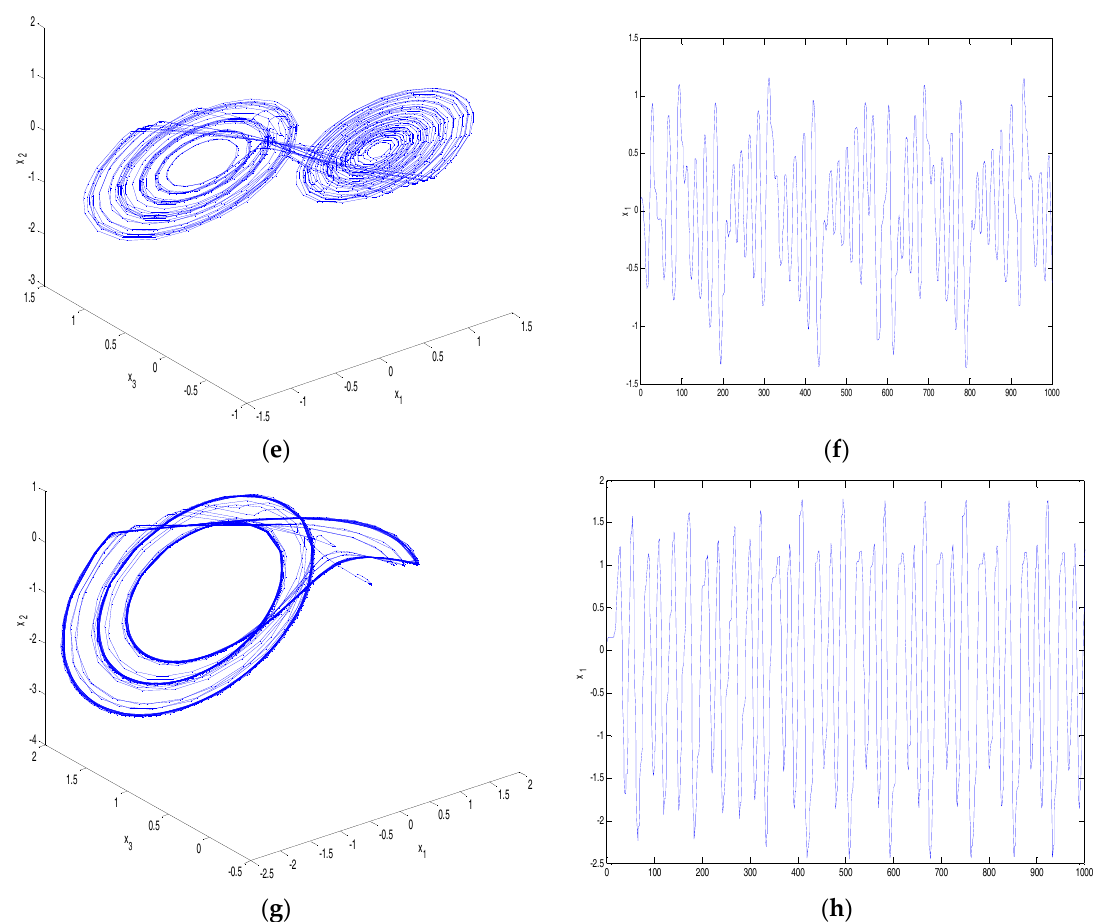
Figure 1. Numerical results of the Switched ‐ SC ‐ CNN Based system: ( a ) 3T ‐ periodic solution for i 33 = − 0.83; ( b ) time response of x 1 (t) dynamic for i 33 = − 0.83; ( c ) one band chaos for i 33 = − 0.59; ( d ) time response of x 1 (t) dynamic for i 33 = − 0.59; ( e ) double scroll for i 33 = 0.1; ( f ) time response of x 2 (t) dynamic for i 33 = 0.1; ( g ) 3T ‐ periodic solution for i 33 = 0.83; and ( h ) time response of x 1 (t) dynamic for i 33 = 0.83.